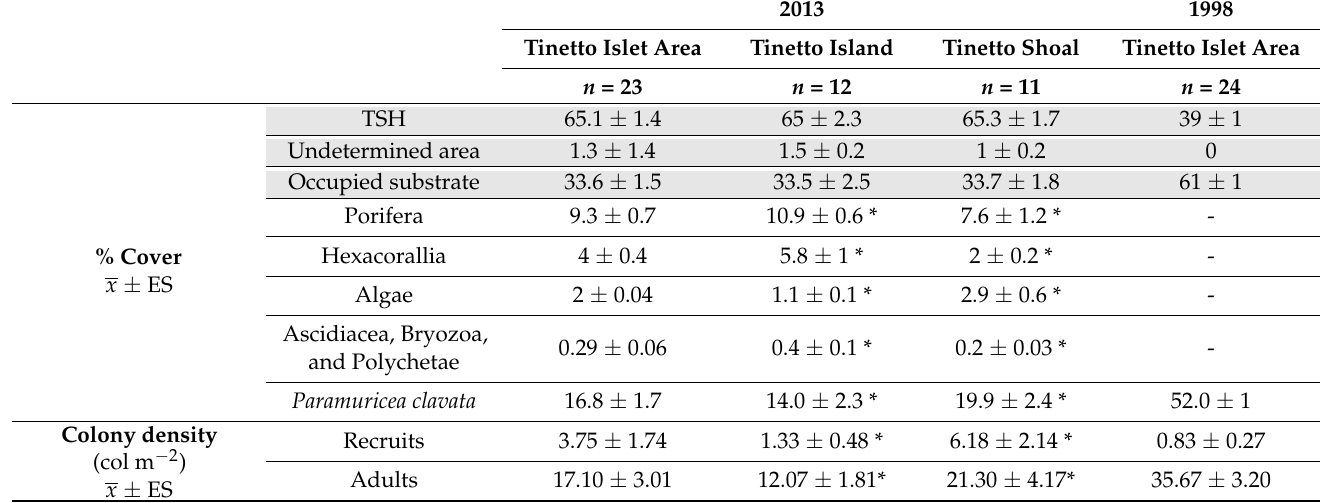
Table 1. Percent cover (%) of the whole Tinetto Islet area and two sites (Tinetto Island and Tinetto Shoal) in 2013 and 1998 [46]. The TSH substrate is composed by algal turf, sediment, and small hydrozoans; occupied substrate includes sessile macro-benthonic organisms listed below. * = p < 0.05 level. TSH, occupied substrate, density of P. clavata adults and recruits (col m − 2 ) in the whole Tinetto Islet area in 2013 are compared with those measured in 1998